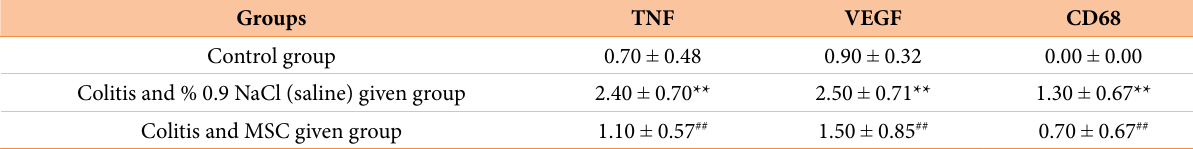
Table 3 - The results of immunohistochemical